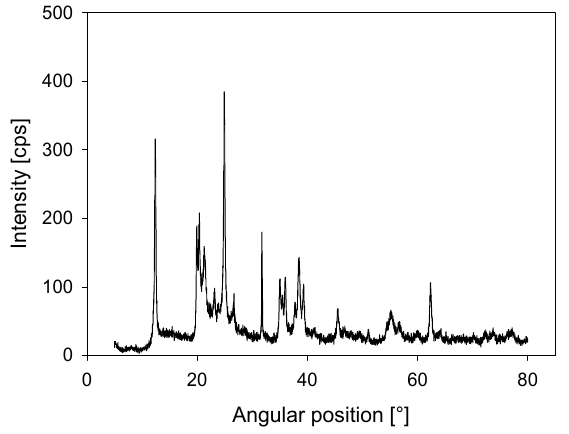
ff raction (XRD) for kaolin Figure 1. X-ray diffraction (XRD) for kaolin powder. Figure 1. X-ray di